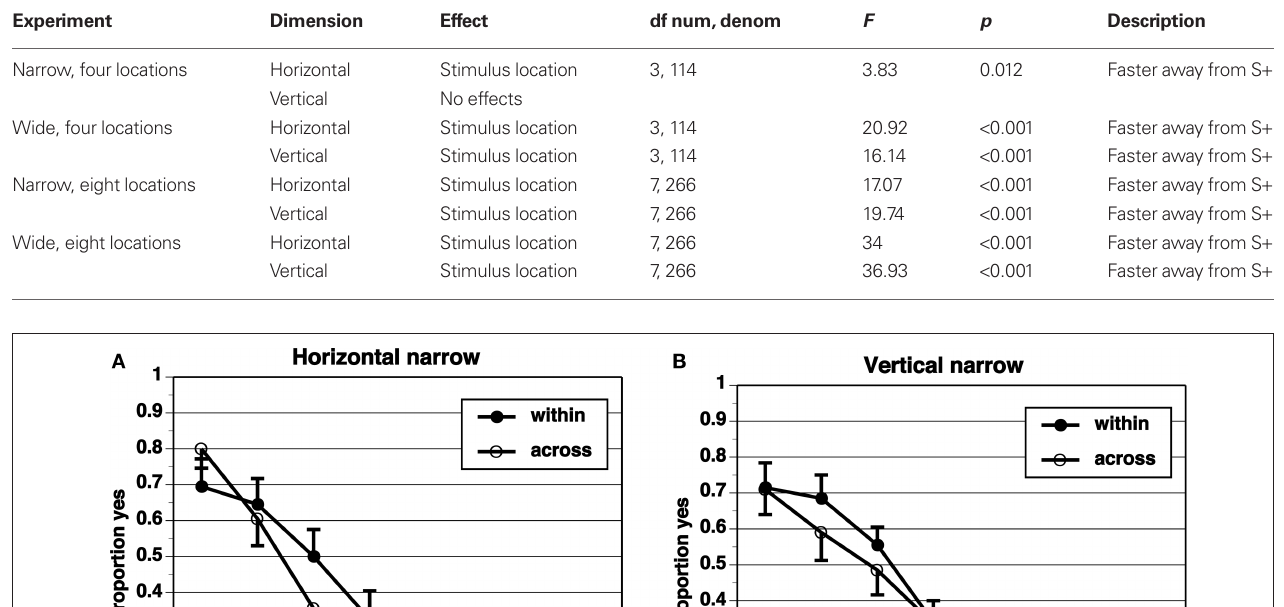
Table 2 | Statistical effects for reaction